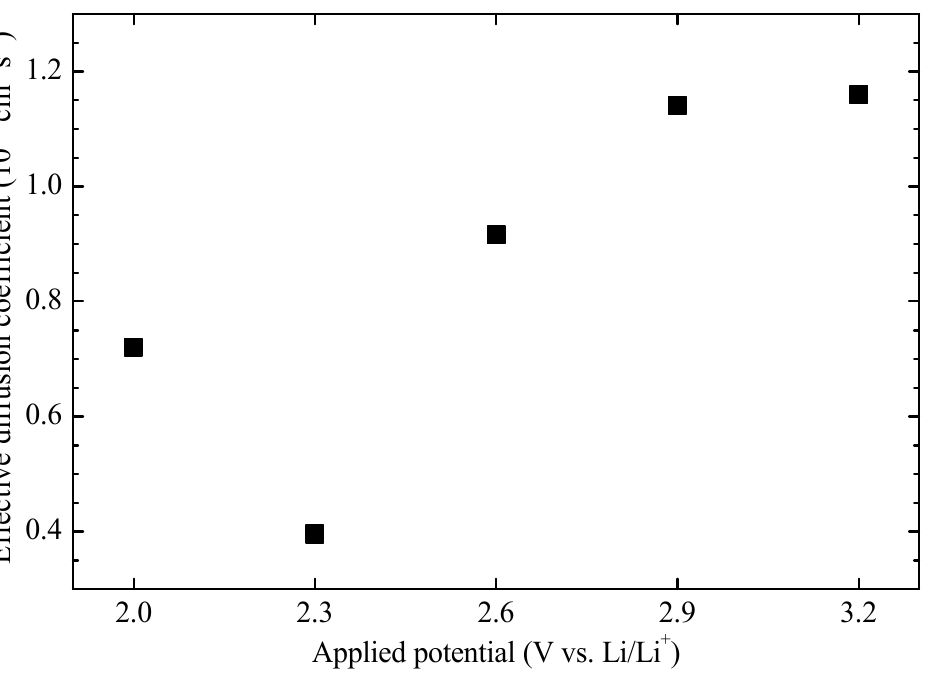
Figure 6. Effective diffusion coefficient of Li + ions as a function of potential vs. Li/Li + for ~300-nm- thick HWO x films.